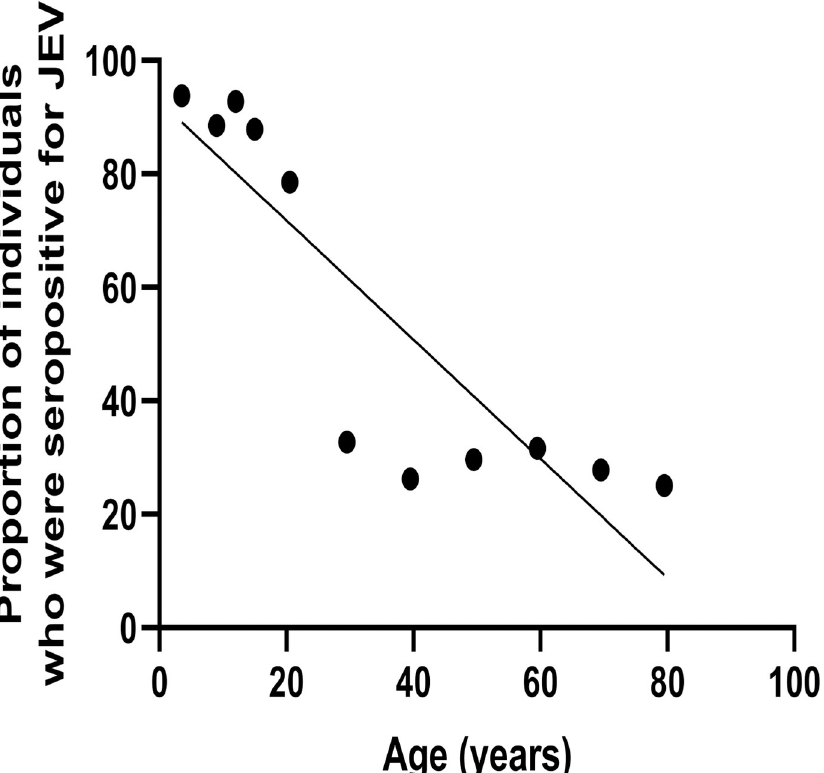
Fig 4. Age stratified seroprevalence of JE-specific antibodies. JEV-specific antibodies were measured using the in- house ELISA in 520 healthy individuals. JEV-specific antibody seropositivity significantly decreased with age. The correlation of JEV-specific antibodies with age was measured by the Spearmans’ rank correlation (Spearmans’ R = -0.85, p = 0.003).